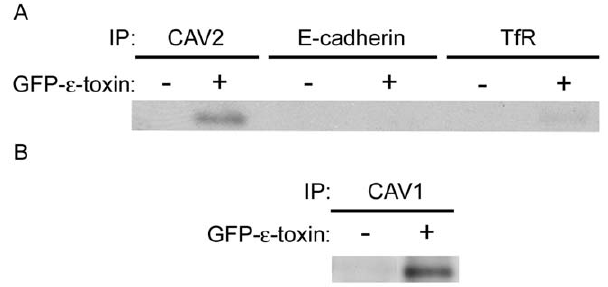
Figure 8. Toxin binding and oligomerization. A) Non-transfected ACHN cells, or cells transfected with shRNA specific for GAPDH or CAV2 were treated with GFP-labeled toxin. Whole cell lysates were analyzed by immunoblotting with GFP antibody. Non-transfected ACHN cells in the absence of toxin served as a control. A representative immunoblot is shown. B) Non-transfected ACHN cells, or cells transfected with a non- targeting shRNA or with CAV1 -specific shRNA were treated with GFP- labeled toxin. Whole cell lysates were analyzed by immunoblotting with GFP antibody. Non-transfected ACHN cells in the absence of toxin served as a control. A representative immunoblot is